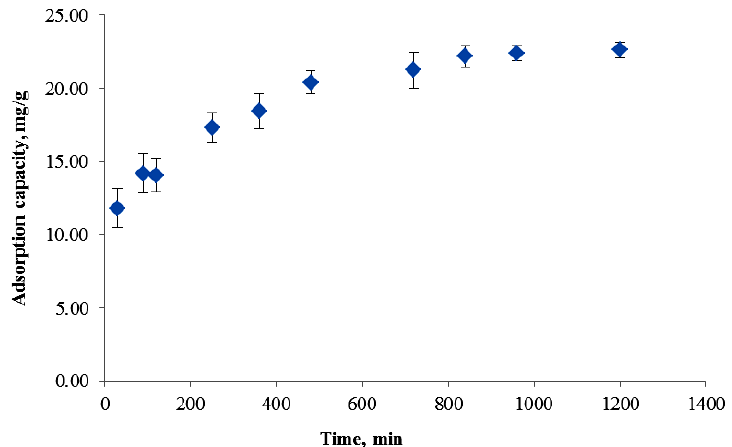
Figure 5. Adsorption capacity towards Ni(II) ion at different